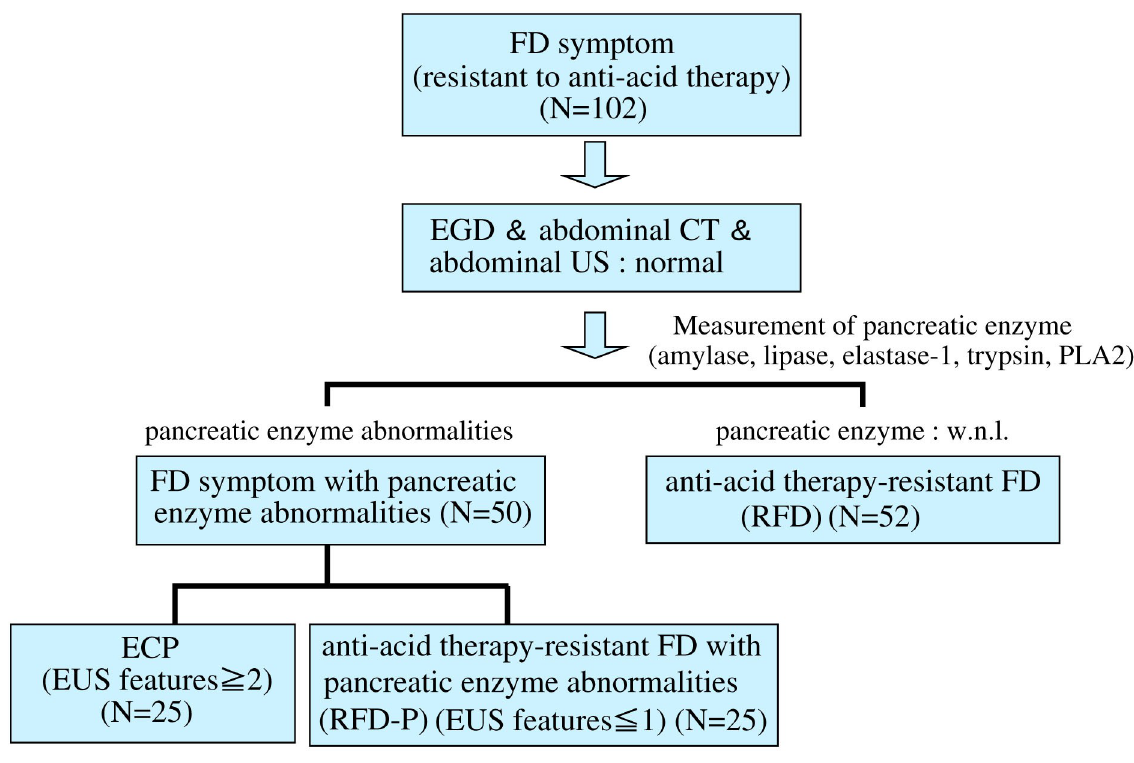
Fig 1. Flowchart of this